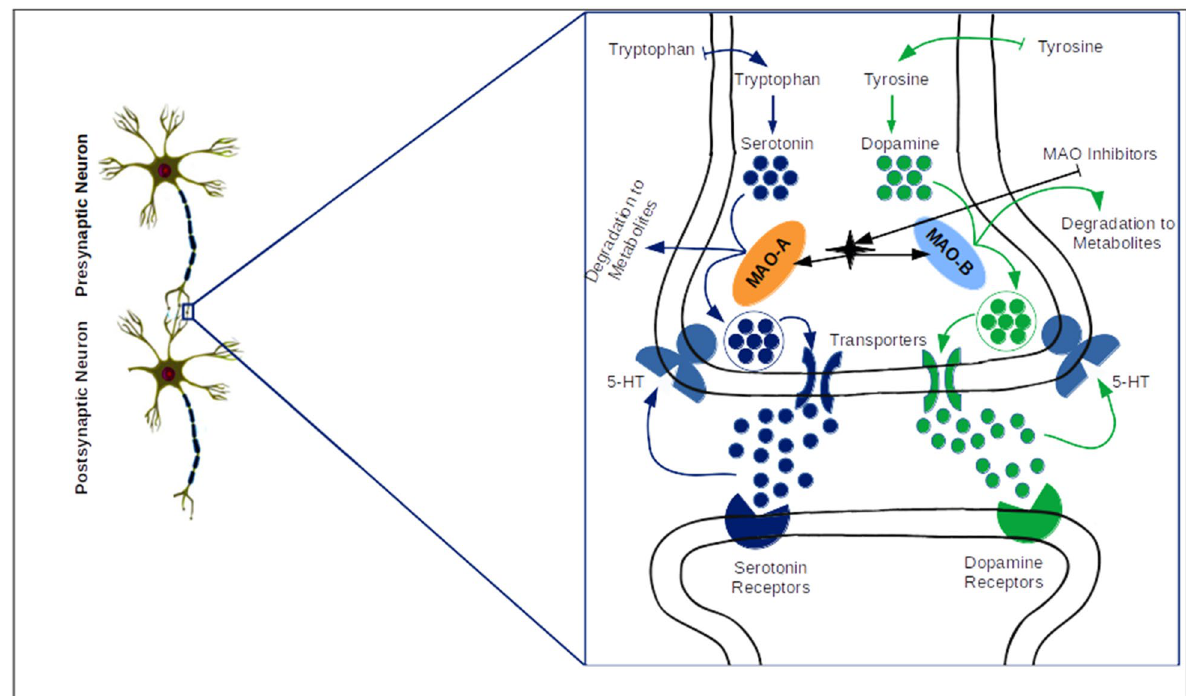
Fig. 1 Simplified schematization of the mechanism of action of monoamine oxidase